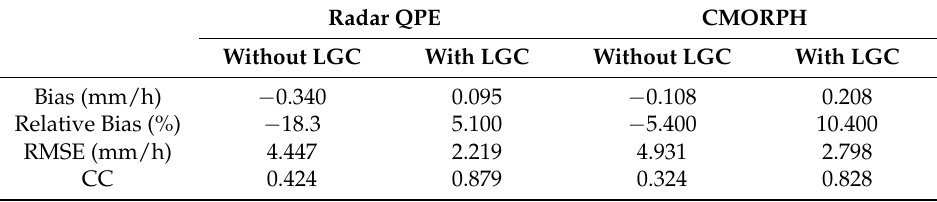
Table 4. Cross-validation results for the radar and satellite estimates with and without the LGC. Radar QPE CMORPH Without LGC With LGC Without LGC With LGC Radar